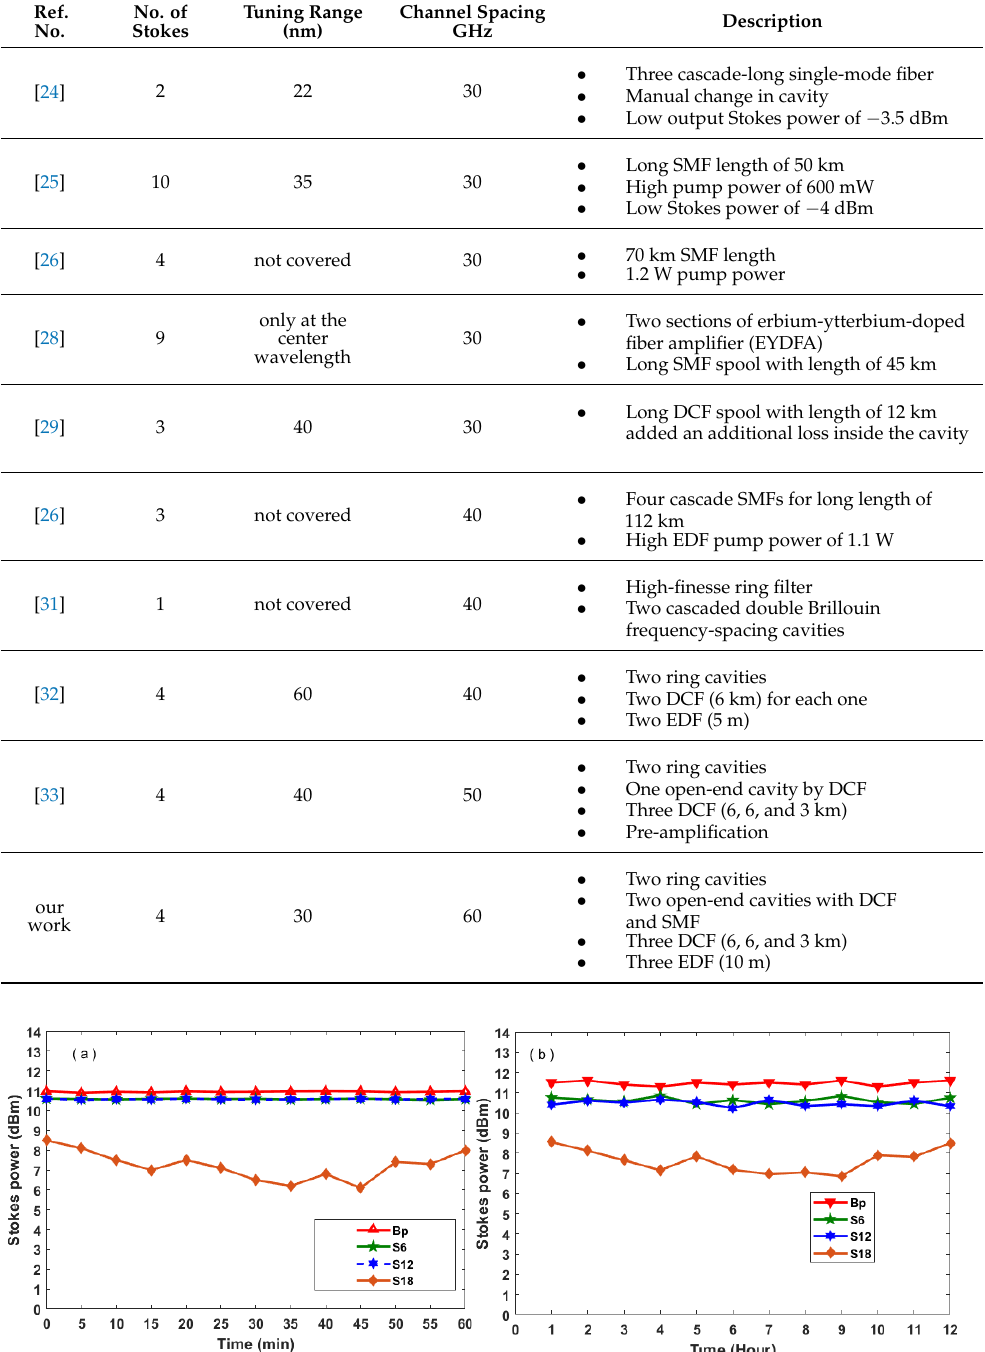
Table 1. Summary of different Brillouin frequency shifts in multiwavelength fiber laser with our work. Ref. No.